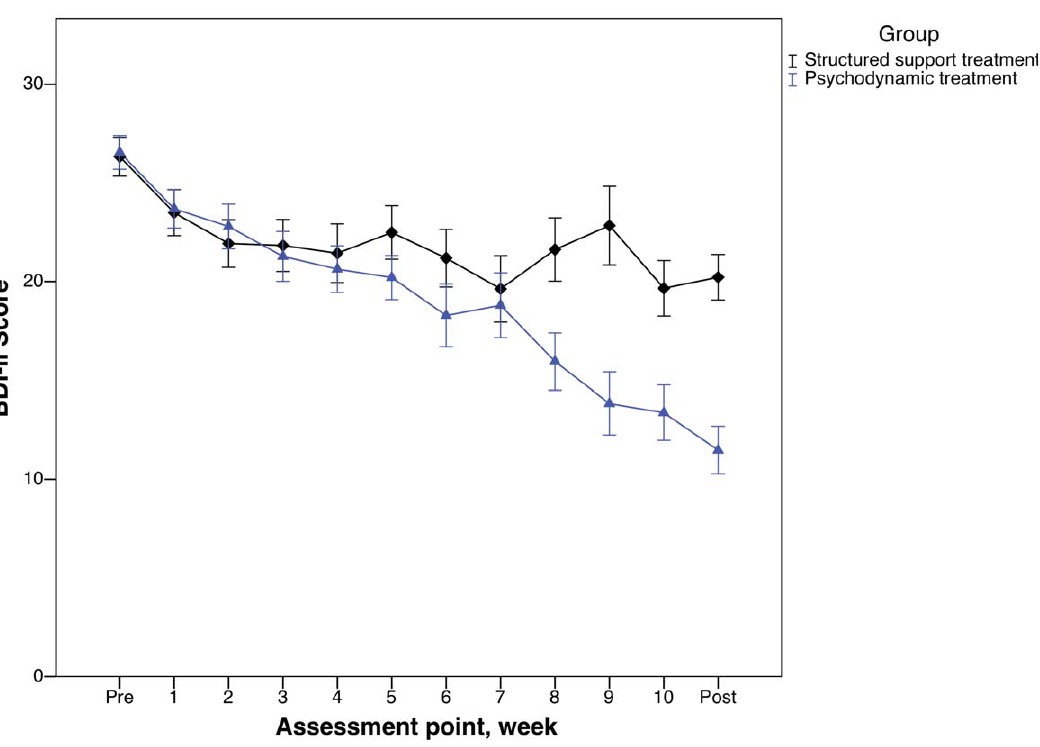
Figure 3. Weekly change on the Beck Depression Inventory-II during treatment and Beck Depression Inventory-II scores at each assessment point.